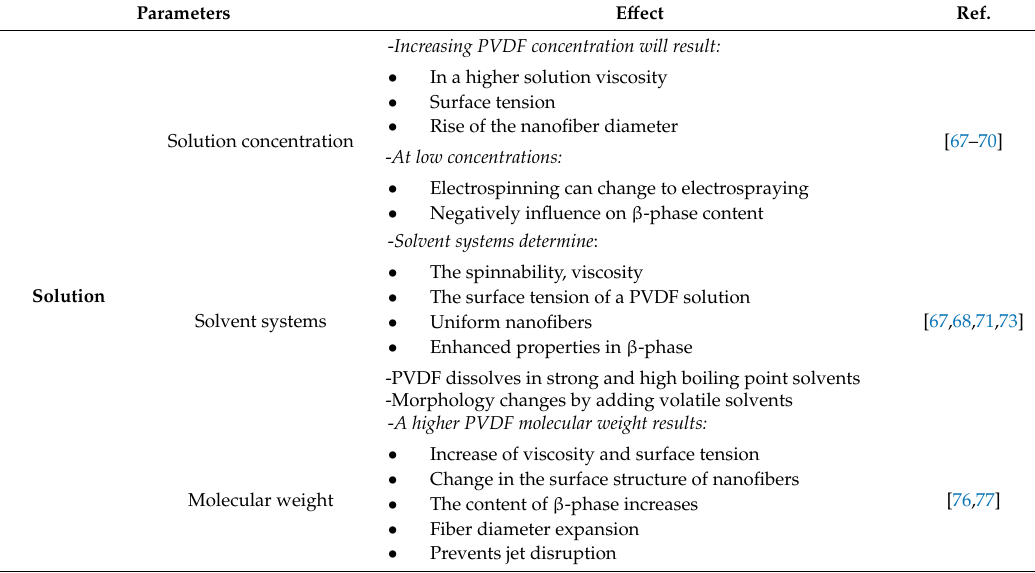
Table 2. The e ff ect of electrospinning process parameters. E ff ect